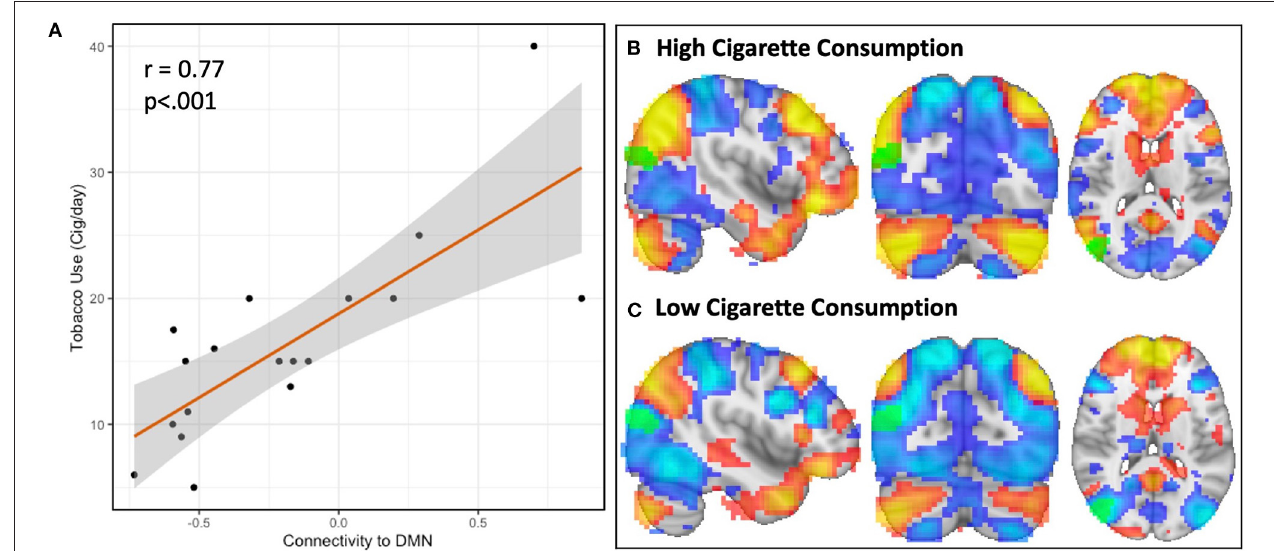
FIGURE 3 | Resting-state network topography is strongly linked to cigarette consumption in schizophrenia. The spatial organization of resting-state networks is strongly linked to cigarette consumption in schizophrenia. In the first step of MDMR, we identified a parieto-occipital region where functional connectivity correlated with daily tobacco use ( Figure 1 ). In order to determine the direction and spatial pattern of connectivity to this parieto-occipital region, we conducted follow-up seed-based analysis within the schizophrenia cohort. This region was connected to the default mode network (DMN), which was readily identified by visual inspection. We therefore measured the functional connectivity between our MDMR-identified region and the DMN. When we compared tobacco use (cigarettes per day) with connectivity to the DMN, we observed a linear relationship where greater daily cigarette consumption was significantly correlated with greater connectivity to the DMN [ (A) , r = 0.77, p < 0.001]. This indicates that, with increasing daily cigarette consumption, the identified parieto-occipital region is increasingly connected to the DMN rather than to other networks. We determined this relationship was due to the topography of the DMN, as evidenced by two representative individuals (B,C) . Displayed here are the DMN (red) and dorsal attention network (DAN, blue) in two example individuals diagnosed with schizophrenia with either high (B) (40 cigarettes/day) and low (C) (5 cigarettes/day) cigarette consumption. In an individual with high daily cigarette consumption (3B), the DMN extends into the parieto-occipital region identified using MDMR ( k = 52, MNI x = 42, y = − 78, z = 18, green) while the DAN does not; in an individual with low daily cigarette consumption (C) , the DMN is external to this region and this region is part of the DAN. This link between network topography and cigarette consumption was not observed in a comparison group of nicotine-dependent